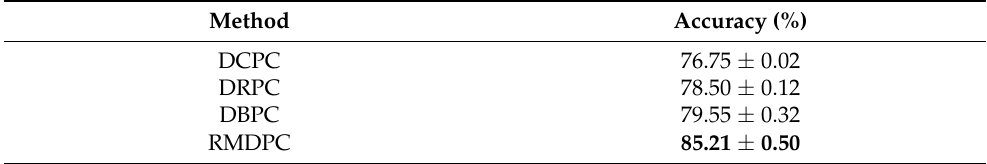
Table 3. Comparison with other patent deep classification methods.